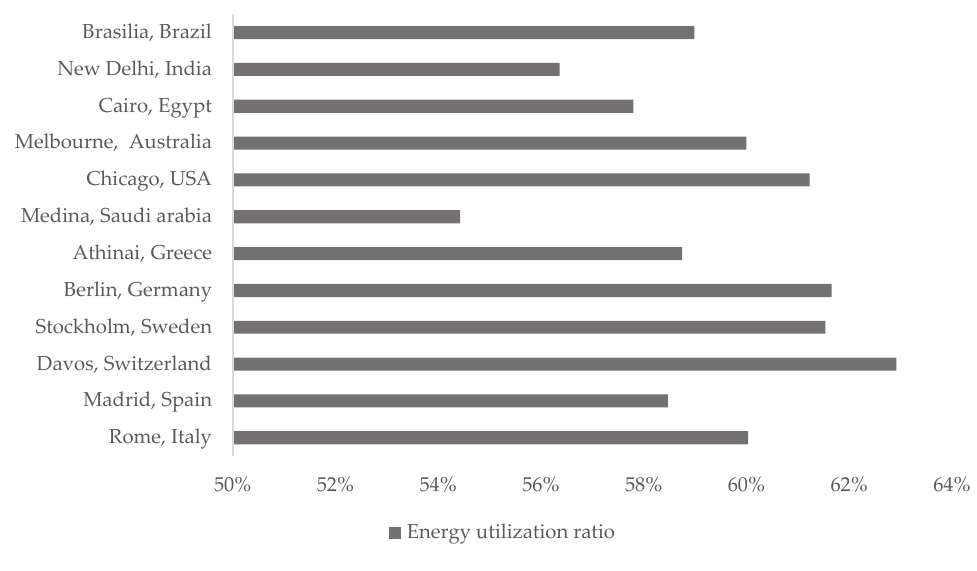
Figure 13. Collector monthly electrical production variation.